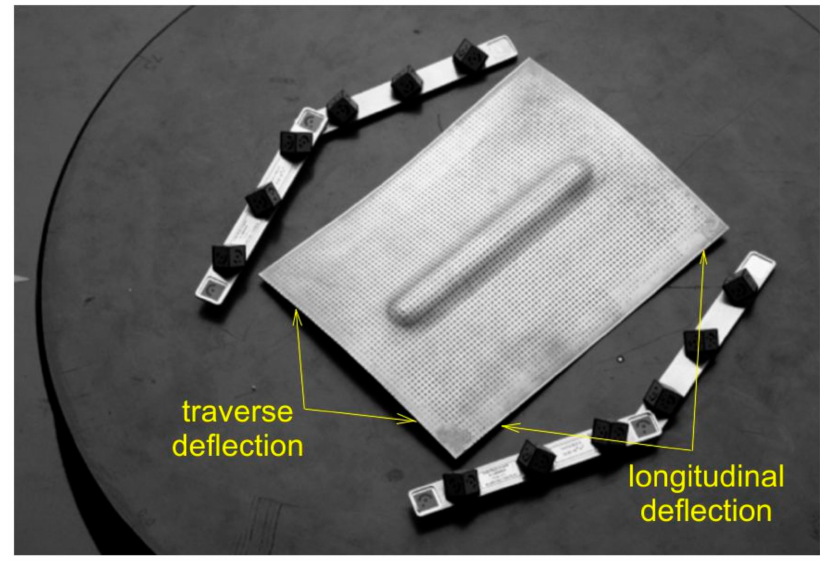
Figure 6. The view of the panel with grid of